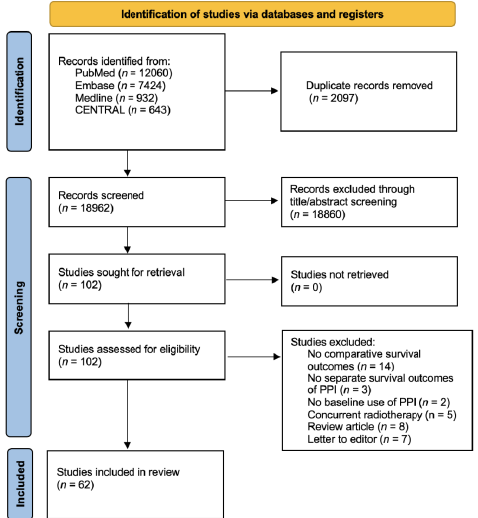
Figure 1. PRISMA flowchart diagram. We initially extracted a total of 21,059 potential references, including 12,060 from PubMed, 7424 from Embase, 932 from Medline, and 643 from CENTRAL. After a duplicate exclusion, 18,962 studies were identified. Screening the titles and abstracts yielded 102 full-text articles, the eligibility of which was assessed. Forty studies were excluded after reading whole texts owing to reasons elaborated in Supplementary Results 1. Eventually, 62 studies fulfilled the eligibility criteria and were included for qualitative and quantitative syntheses. PRISMA, Pre- ferred Reporting Items for Systematic Reviews and Meta-Analyses.